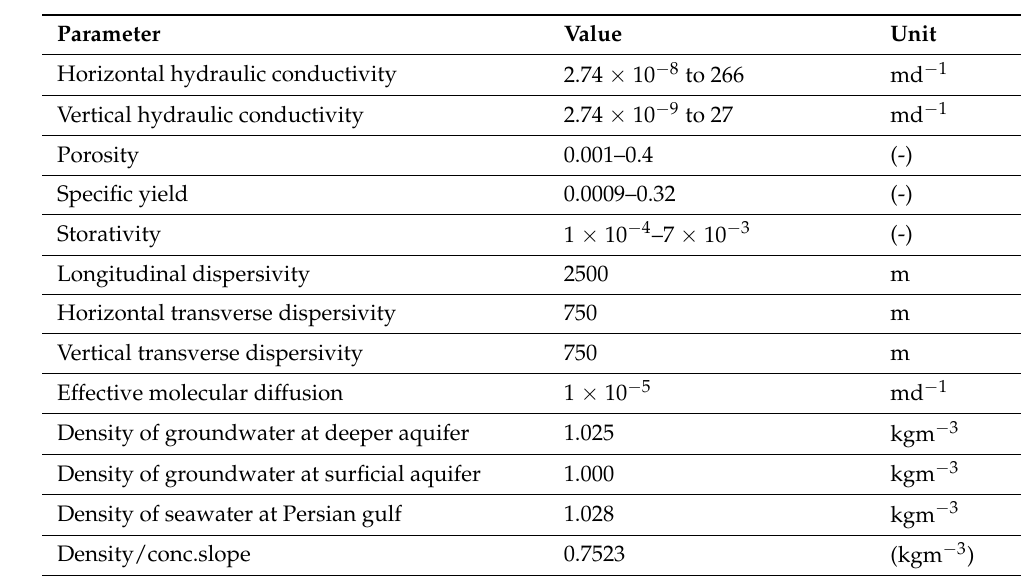
Table 2. Calibrated flow and solute transport parameters.